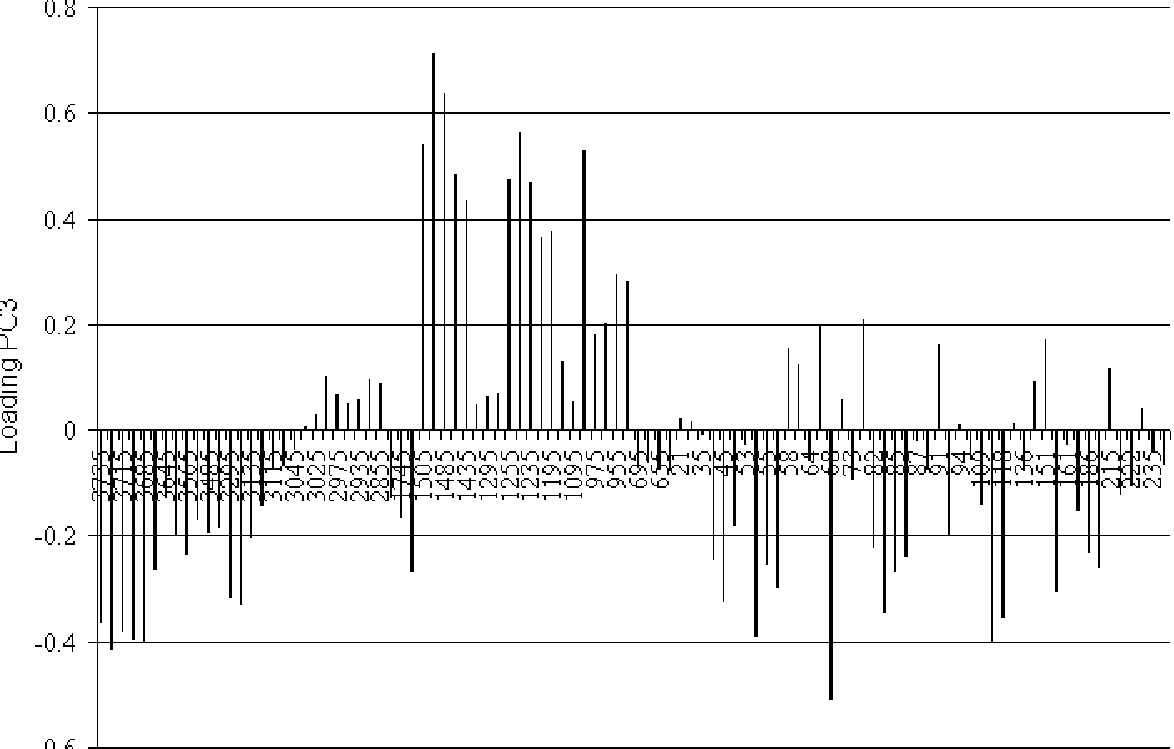
Figure 5. Loading plot identifying the variables (IR absorptions and m / z fragment ions) with the most important discrimination